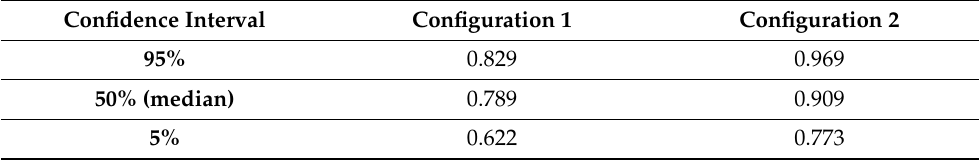
Table 3. Resilience scores for Configurations 1 and